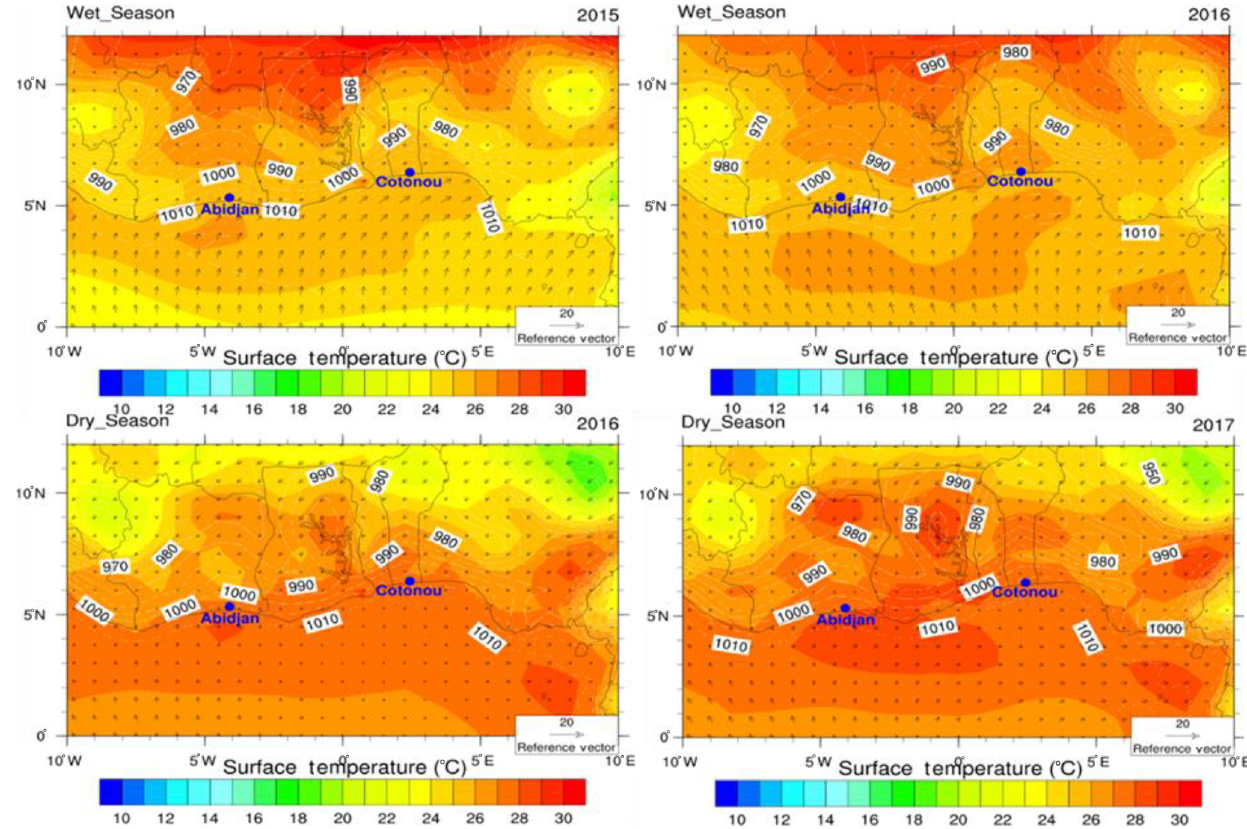
Figure 4. Wind, pressure, and temperature diagram at Abidjan and Cotonou during the different